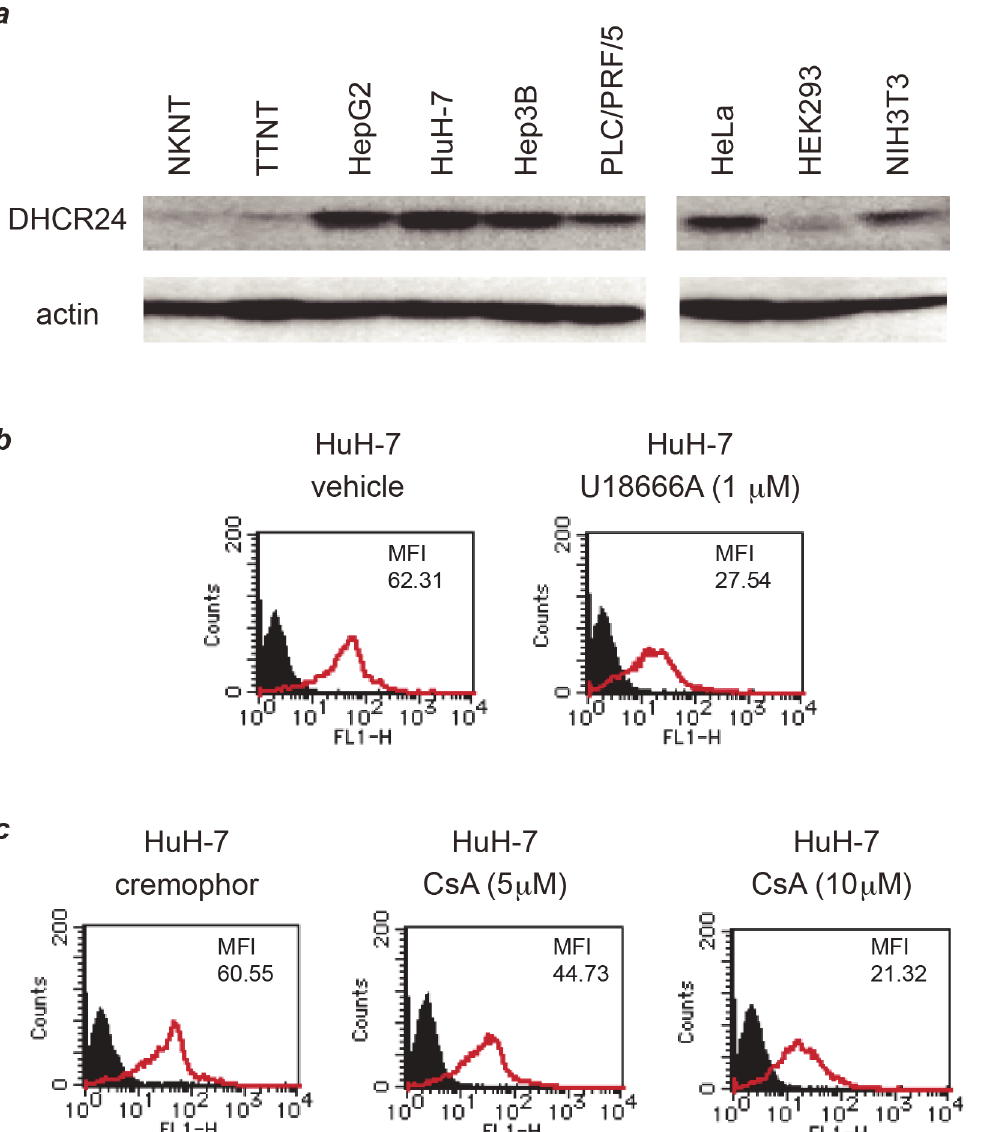
Fig 1. Overexpression of DHCR24 on the cell surface of HCC cell lines was decreased by treatment with U18666A and cyclosporin A. ( a ) Cell lysates of each cell line (containing 50 μ g of protein) were separated by 10% SDS-PAGE and analyzed by western blotting with 2-152a MAb and an anti-actin MAb. Normal hepatic cell lines: NKNT, and TTNT. HB-derived cell line: HepG2. HCC-derived cell lines: HuH-7, Hep3B, and PLC/PRF/5. ( b ) HuH-7 cells were treated with U18666A (final concentration, 1 μ M) for 48 h, and then the surface expression of DHCR24 was analyzed by flow cytometry. ( c ) HuH-7 cells were treated with cyclosporin A (final concentration, 5 or 10 μ M) or solvent (cremophor) for 48 h, and then the surface expression of DHCR24 was analyzed by flow